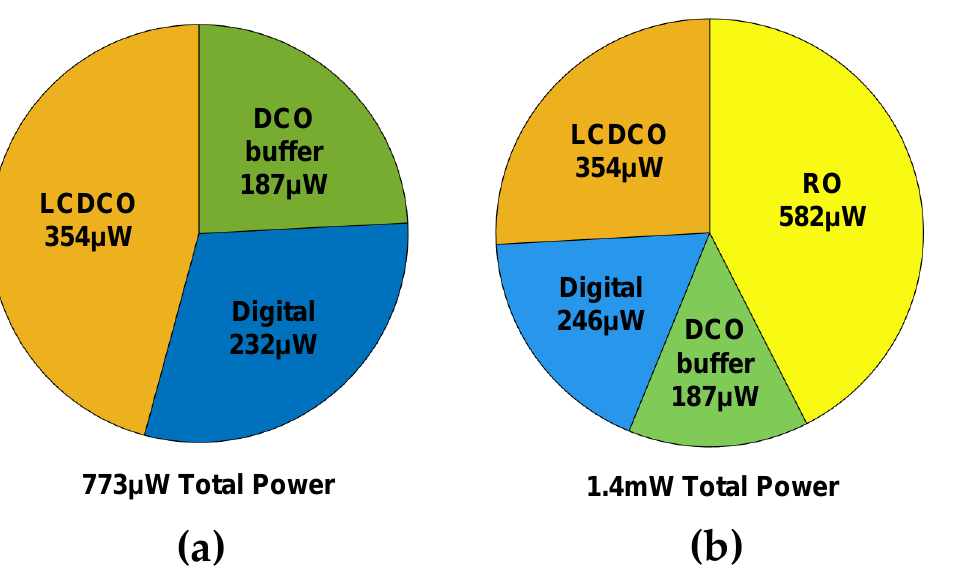
Figure 21. ADPLL power breakdown in ( a ) coarse mode, medium mode, and ( b ) RO tuning mode and fine mode.